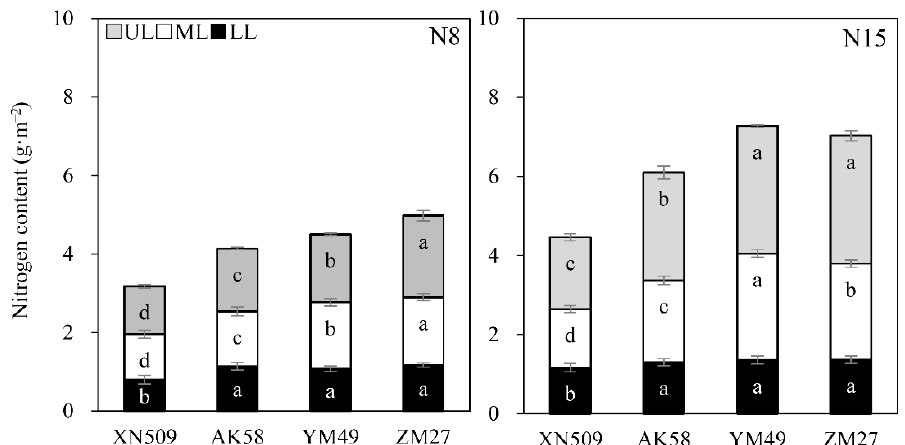
Figure 6. The vertical distribution of the leaf N content of two N-efficient and two N-inefficient winter wheat varieties under different N levels. UL: upper layer. ML: middle layer. LL: lower layer. Different letters within each column indicate significant differences according to Duncan’s multiple-range test ( p = 0.05).